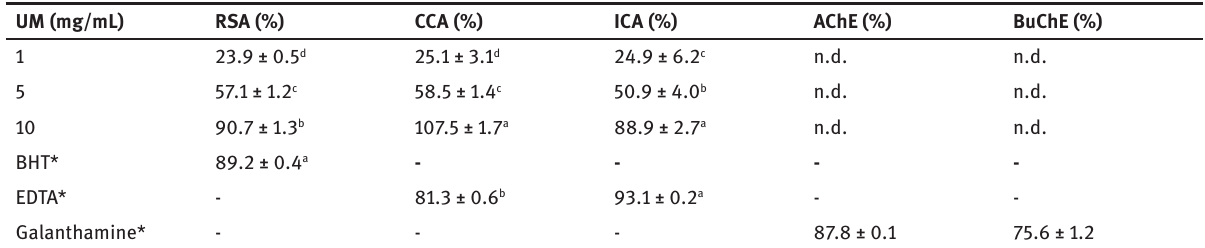
Table 1: Radical scavenging activity (RSA), metal chelating activity towards copper (CCA) and iron (ICA) ions and acetylcholinesterase (AChE) and butyrylcholinesterase (BuChE) inhibition activities of